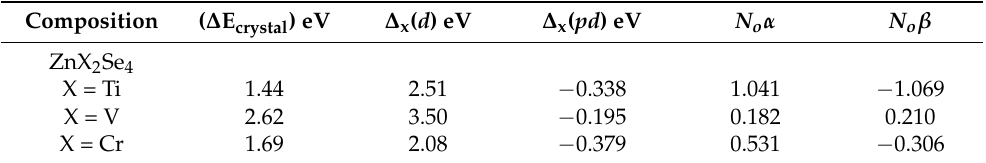
Table 2. The computed (crystal field energy) ∆ E crystal , interchange energy ∆ x ( d ), pd -exchange energy ∆ x ( pd ) and interchange constants ( N o α and N o β ) of ZnX 2 Se 4 (X = Ti, V, Cr). Composition ( ∆ E crystal ) eV ∆ x ( d ) eV ∆ x ( pd ) eV N o α N o β ZnX 2 Se 4 X = Ti 1.44 2.51 − 0.338 1.041 − 1.069 X = V 2.62 3.50 − 0.195 0.182 0.210 X = Cr 1.69 2.08 − 0.379 0.531 −